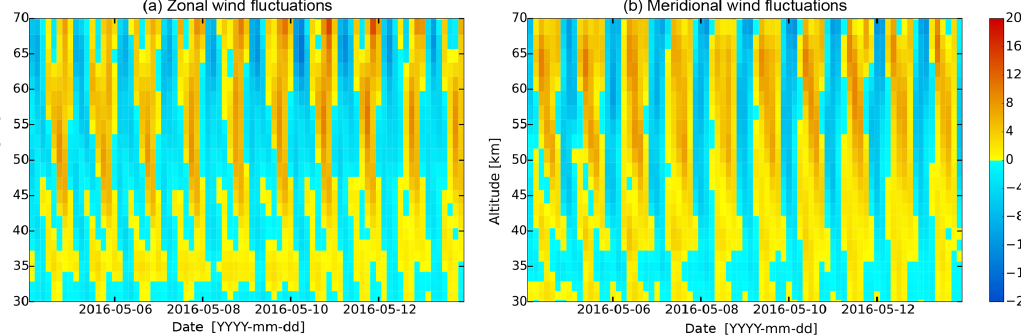
Figure 4. Tidal fluctuations derived from the zonal (a) and meridional winds (b) given by MERRA-2 for the same period in May